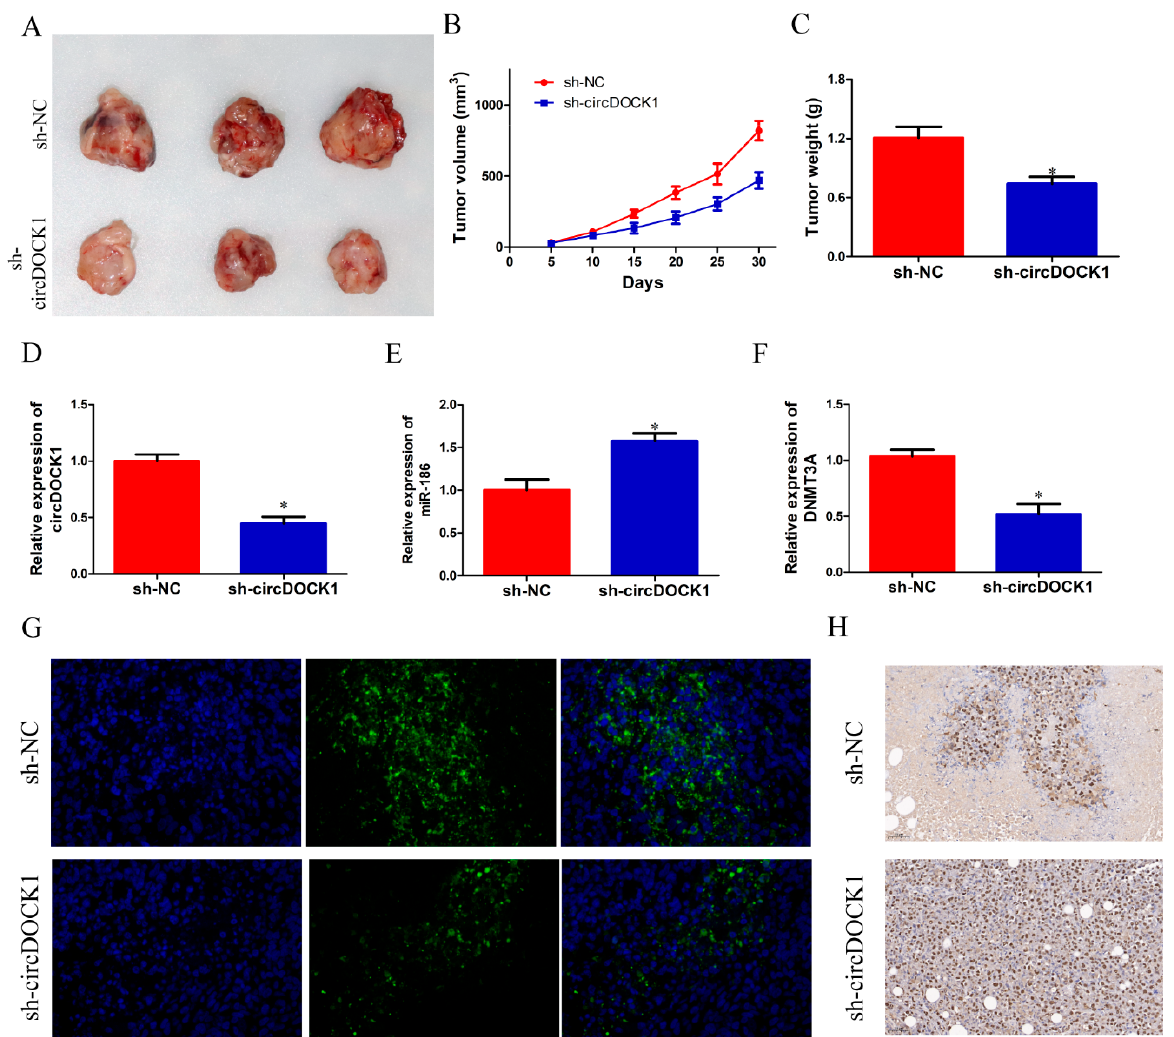
Figure 7. CircDOCK1 knockdown suppressed OS growth in vivo. ( A ) The tumor mass images. ( B , C ) The volume and weight information of tumors in both groups. ( D – F ) The tumor tissue levels of circDOCK1, DNMT3A, and miR-186. ( G ) Immunofluorescence staining of DNMT3A. ( H ) Ki-67 staining of tumor tissues. * p < 0.05.